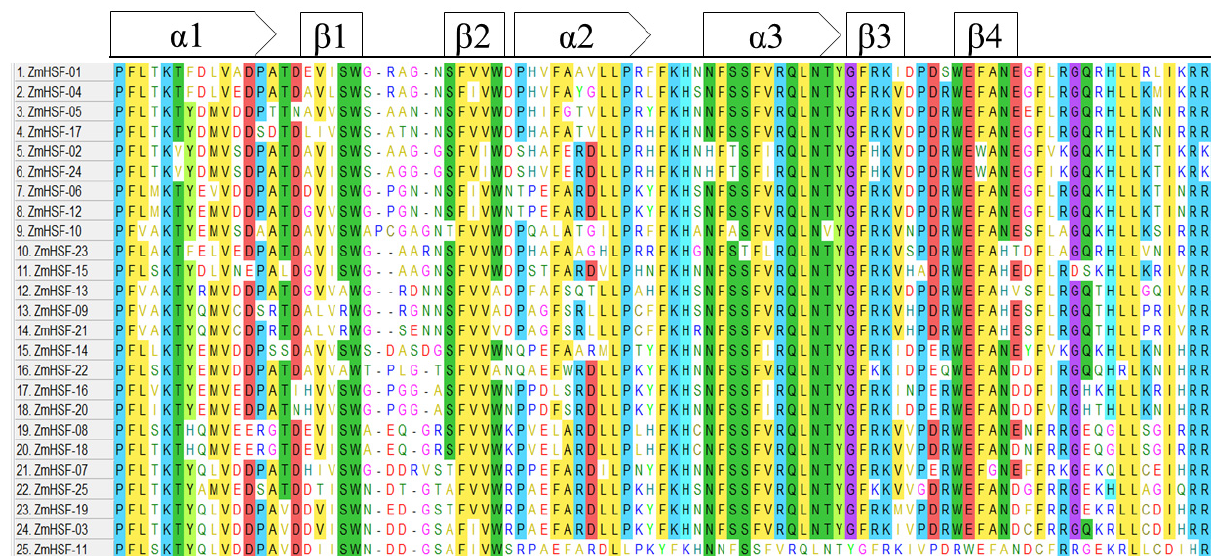
Figure 6. Multiple sequence alignment of maize HSFs. The highly conserved DBD consists of four antiparallel β -stranded sheets ( β 1, β 2, β 3, β 4) and a bundle of three α -helices ( α 1, α 2, α 3) which form the secondary structure. Rectangular boxes represent α -helices while square boxes represent β -stranded sheets.